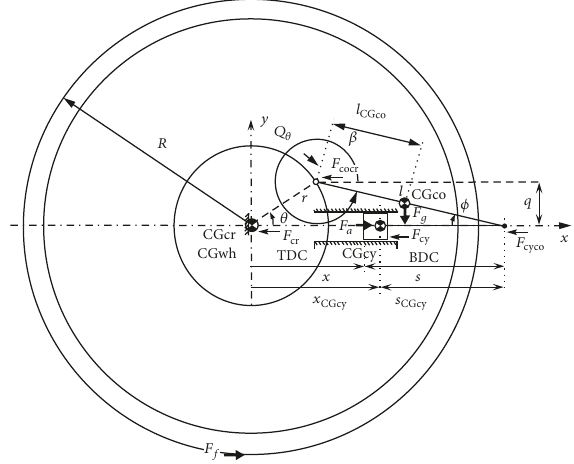
Figure 1: Schematic draw of a compressed air engine composed of pneumatic cylinder and a